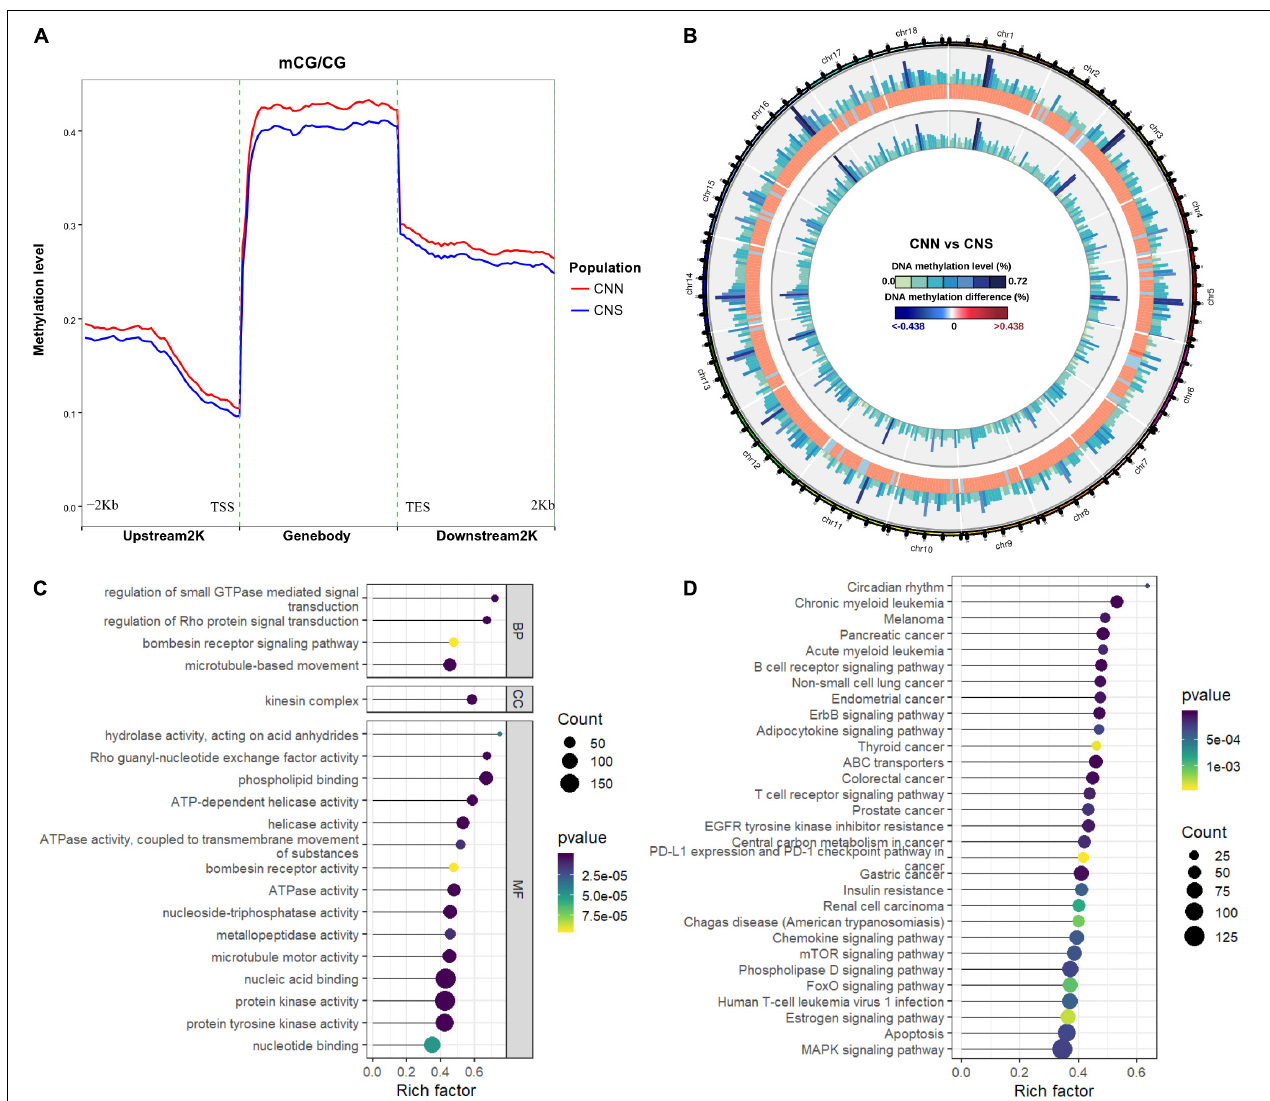
FIGURE 4 | (A) Distributions of DNA methylation levels across the whole H. discus hannai genomic regions between CNN and CNS populations. (B) Circos plot showing the distribution of DNA methylation difference at CG context between CNN and CNS populations across H. discus hannai chromosome-scaled genome. The four circles from outer to inner represent chromosomes of H. discus hannai , the methylation levels of the CNN population, the differences of methylation level between CNN and CNS population (CNN vs. CNS), and the methylation levels of the CNS population, respectively. (C) Scatter plot showing the top 20 enriched GO terms derived from the GO enrichment analysis of DMGs. (D) Scatter plot showing the top 20 enriched KEGG pathways derived from KEGG enrichment analysis of